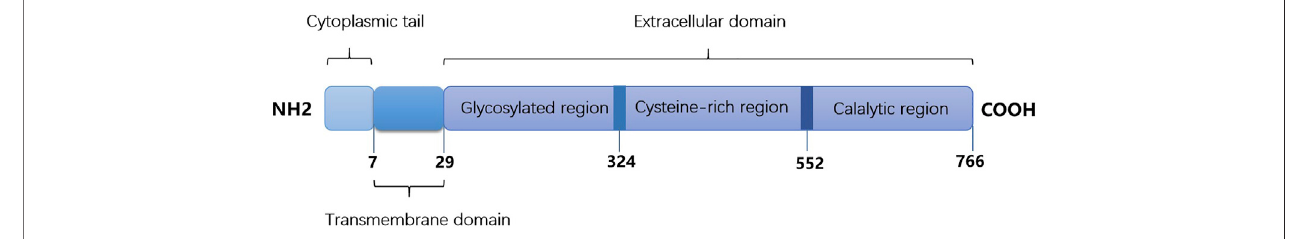
FIGURE 1 | The main structure of DPP4/CD26. It consists of cytoplasmic tail (1-6 amino acids), transmembrane domain (7 – 29 amino acids) and extracellular domain (30 – 766 amino acids).